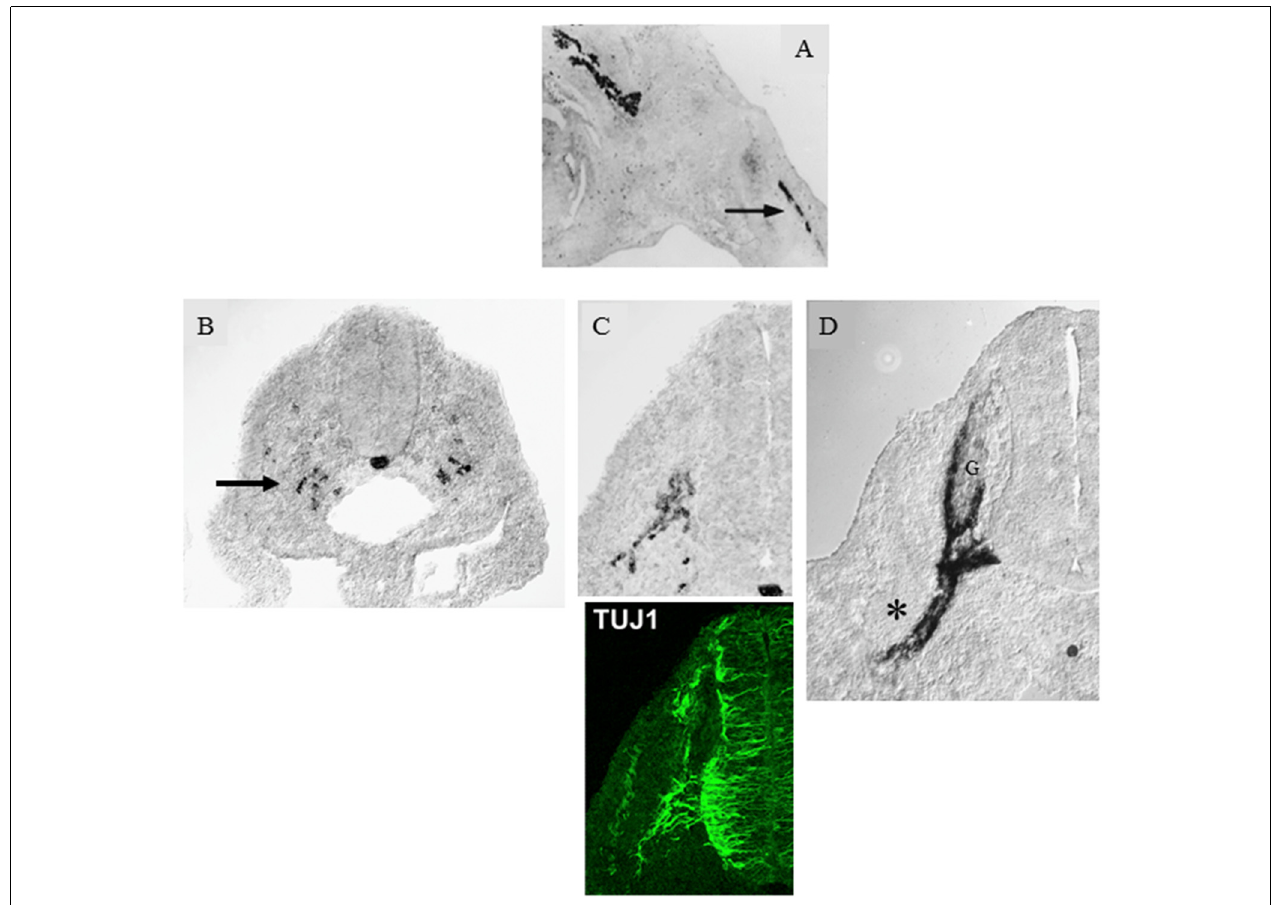
FIGURE 2 | Myelin protein zero (mpz) gene expression at the onset of Schwann cell development. (A) In situ hybridization showing mpz expression in iSch of embryonic (E16) rat nerves (nerve in developing limb arrowed). (B) In situ hybridization showing an initial appearance of mpz expression in scattered neural crest cells at the level with the ventral developing spinal cord (e.g., arrow). Strong mpz labeling is also seen in the notochord. Transverse section from an E9/10 rat embryo. (C) When axons emerge from the ventral spinal cord (shown by TuJ1 immunolabeling in the lower panel), mpz expressing cells cluster nearby (upper panel). Transverse section from an E10/11 rat embryo. (D) In E12/13 rat embryo, mpz expression is seen in nascent spinal nerves (asterisk), and in the ventral root and ventral and lateral aspects of the dorsal root ganglion (G) (with permission, modified from Lee et al.,